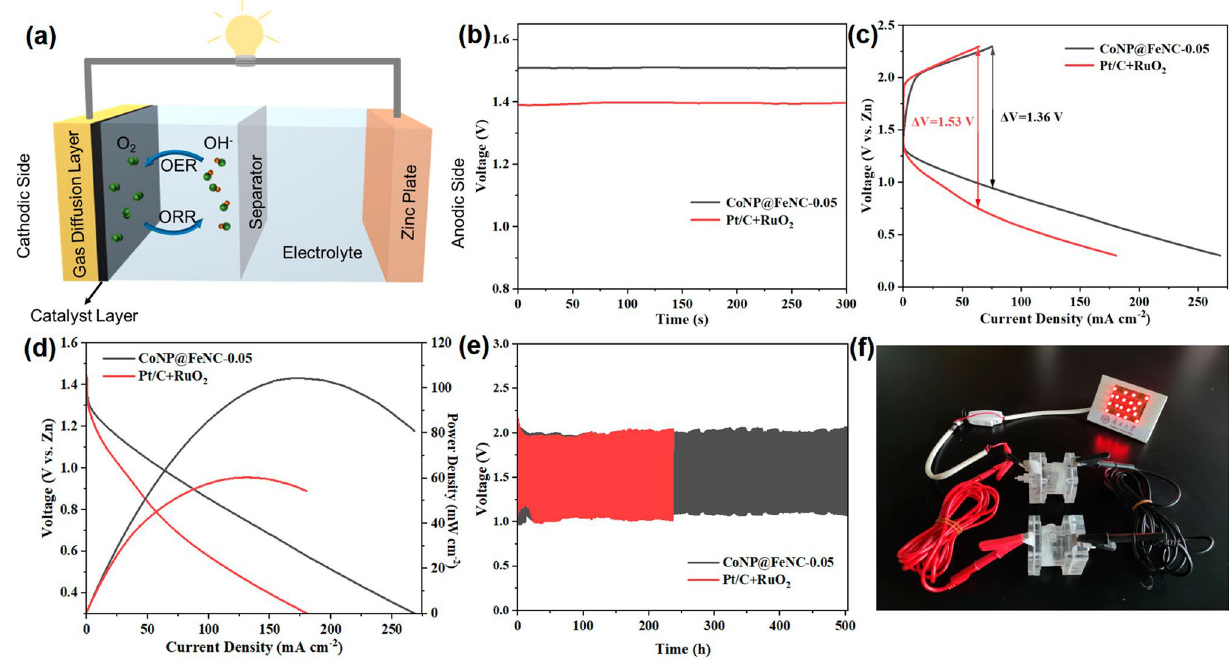
Fig. 5 a Schematic diagram of rechargeable Zn-air batteries. b Open-circuit plots of rechargeable Zn-air batteries. c Charge and discharge polarization curves. d Discharge polarization curves and corresponding power density curves. e Galvanostatic discharge-charge cycling curves. f Photo of a lit LED powered by two Zn-air batteries of CoNP@FeNC-0.05 as cathode catalysts in